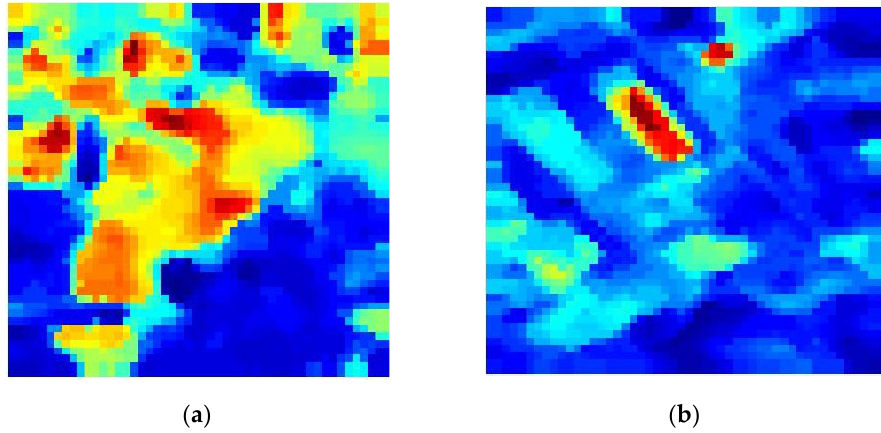
Figure 5. Enhanced images of: ( a ) Indian Pines and ( b ) Pavia